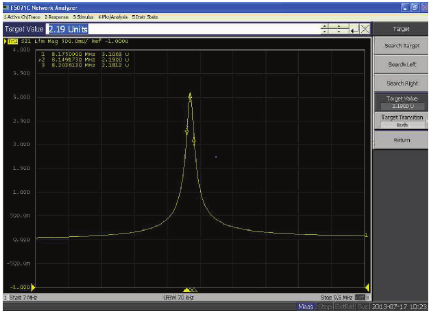
Figure 9: The test result of DTC